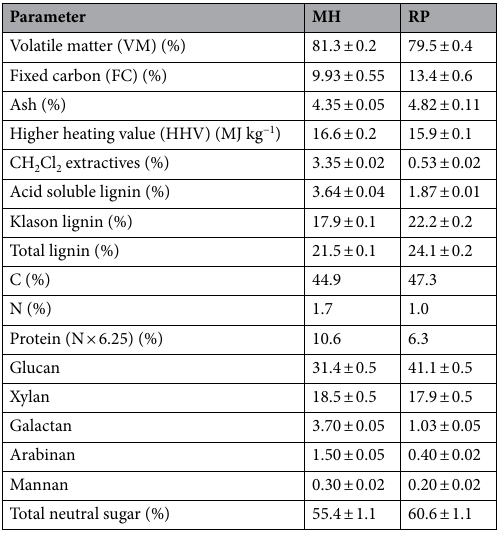
Table 1. Proximate, elemental, and compositional data for MH and RP sample.